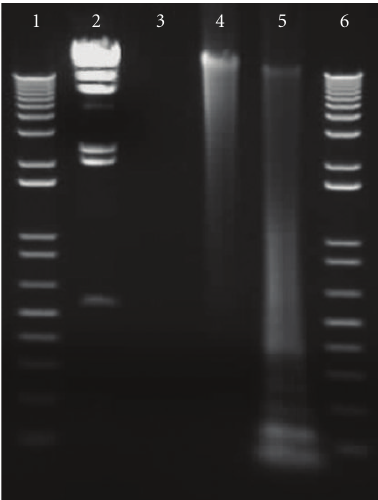
Figure 1: 1% agarose gel loaded with B. anthracis DNA before and after amplification using REPLI-g genomic DNA amplification kit and RsaI digestion. Lanes 1 and 6,: 1kb molecular weight markers, lane 2: Hind III molecular weight marker (23130, 9416, 6557, 4361, 2322, 2027, and 546 bp), lane 3, :5 µ L of 20 ng/ µ L B. anthracis Ba 179 genomic DNA, lane 4,:5 µ L of REPLI-g amplified DNA (355ng/ µ L), and lane 5: RsaI digested